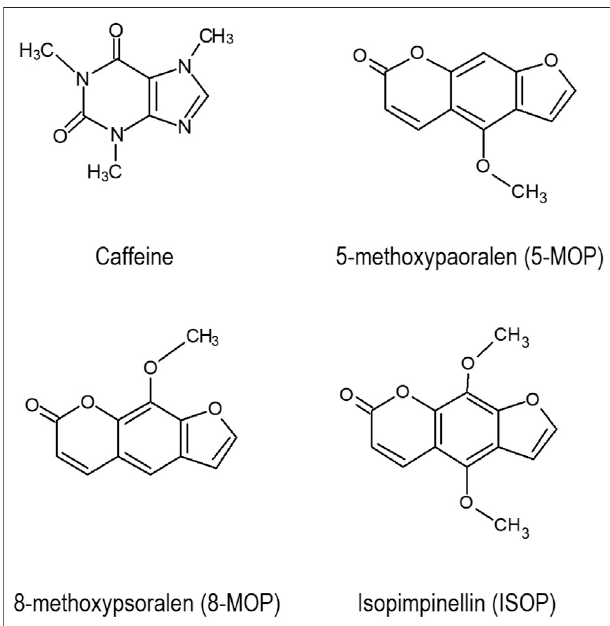
FIGURE 1 | Chemical structures of caffeine and linear